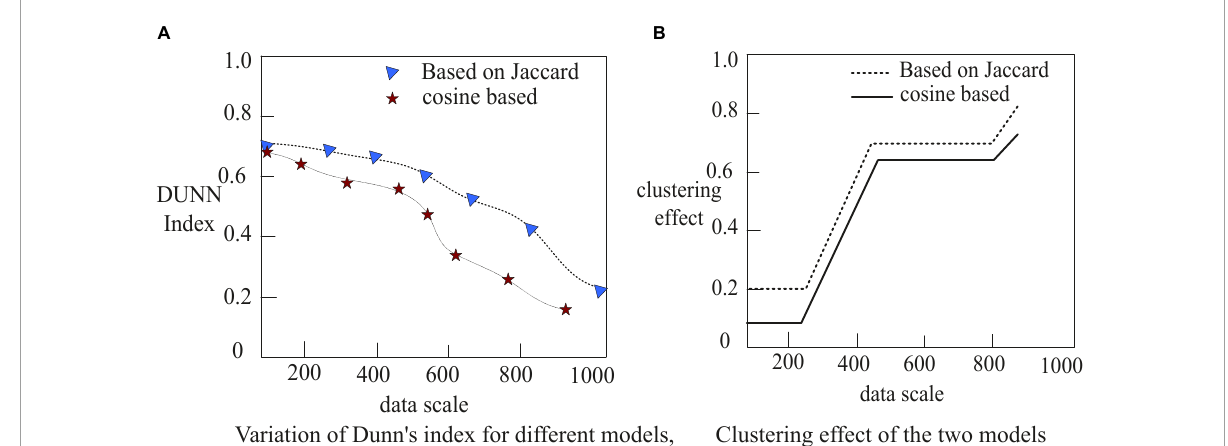
FIGURE6 Simulation results of Dunn’s index as an evaluation criterion. (A) Variation of Dunn’s index for different models. (B) Clustering effect of the two models.